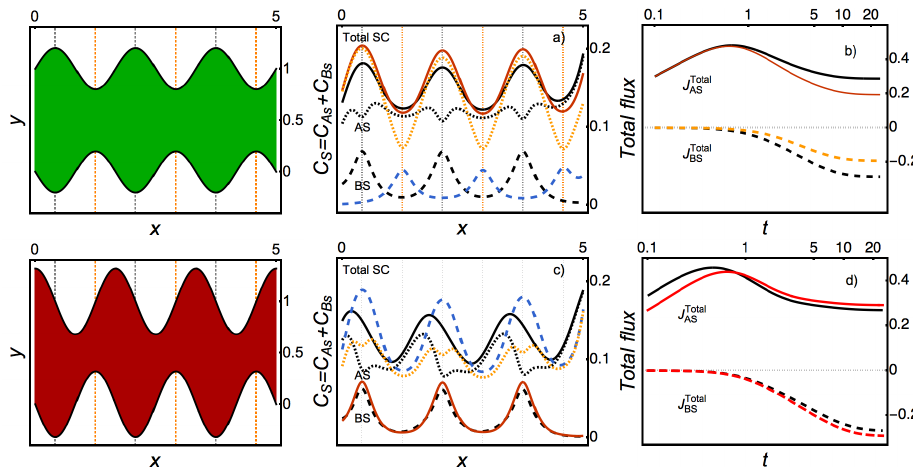
Figure 7. Numerical experiments predicting the surface concentration profiles of the species A and B of the heterogeneous isomerization reaction considered in Section 5.1. The upper line shows the tortuous pore together with the corresponding results Figures ( a , b ). In ( a ) the black lines show to the surface concentrations C AS ( x ) (dotted line) and C BS ( x ) (dashed line) together with the total concentration C = C AS + C BS (solid line) when the active sites are located in the positions indicated by the gray gridlines (corresponding to the wider positions of the pore). The color lines correspond to the same concentrations when the active sites are located in the orange gridlines (corresponding to the narrower positions of the pore). In ( b ) the corresponding diffusion fluxes as a function of time are shown. The bottom line shows a similar situation but for the sinuous pore. Negative values of the flux indicate that the species B leaves the pore at the left end. In ( c ) the solid lines (black and red) show a dramatic change of total mass transport depending on the position of the active sites. This is related with the also dramatic difference of efficiency of the heterogeneous isomerization reaction in this pore, see black and blue dashed lines. The changes are also drastic with respect to the tortuous pore. The total surface fluxes of species A and B are compared in ( d ). The details of the parameters used are given in Appendix